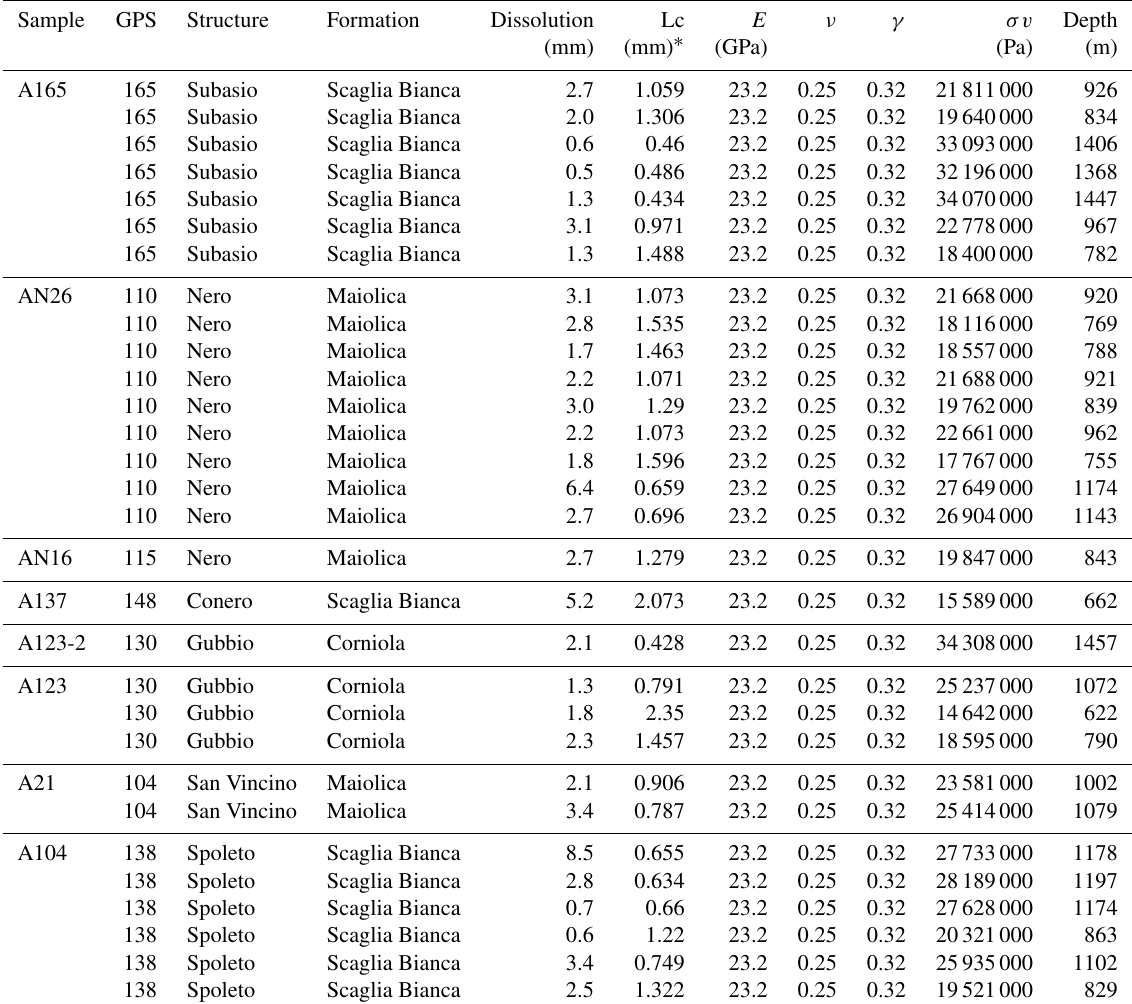
Table 1. Results of stylolite roughness inversion applied on bedding-parallel stylolites.